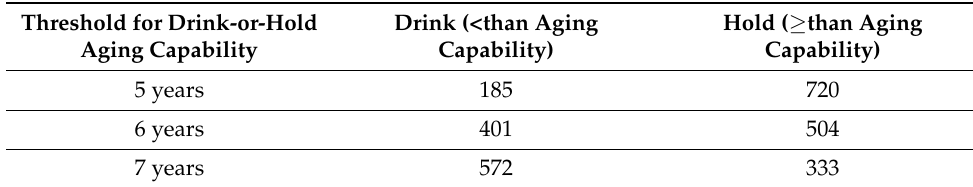
Table 1. The change of the number of the wines receiving the drink or hold class labels, based on different thresholds. If the threshold was set to 5 years, the number of wines (720) classed as Hold is greater more than number of wines (185) classed as Drink. If the threshold is set to 7 years, the number of wines (333) classed as Hold is much less than the number of wines (572) classed as Drink. Therefore, the threshold was set to 6 years to generate a more balanced dataset.